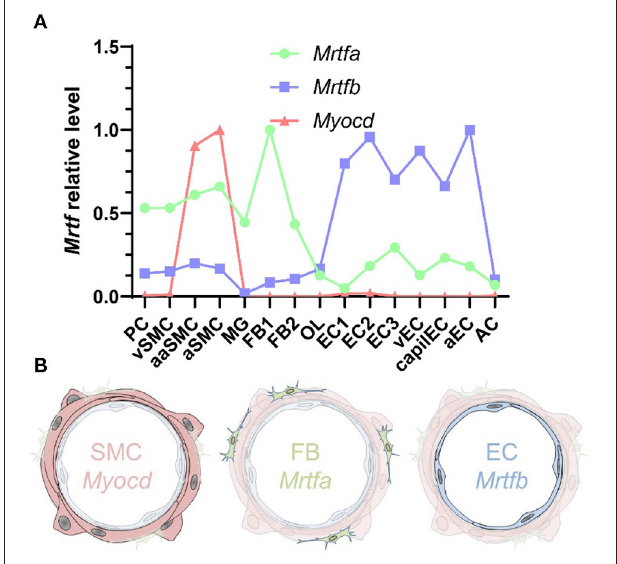
FIGURE 7 | MRTF distribution across the vascular wall. (A) Shows cell-averaged mRNA expression data for the indicated transcripts in different cerebrovascular cell types. PC, pericytes; SMC, smooth muscle cells; MG, microglia; OL, oligodendrocytes; FB, fibroblasts; EC, endothelial cells; AC, astrocytes; v, venous; cap, capillary; a, arterial; aa, arteriolar; and 1, 2, and 3, subtype. (B) Shows a schematic representation of Myocd in SMCs, Mrtfa in FBs, and Mrtfb in